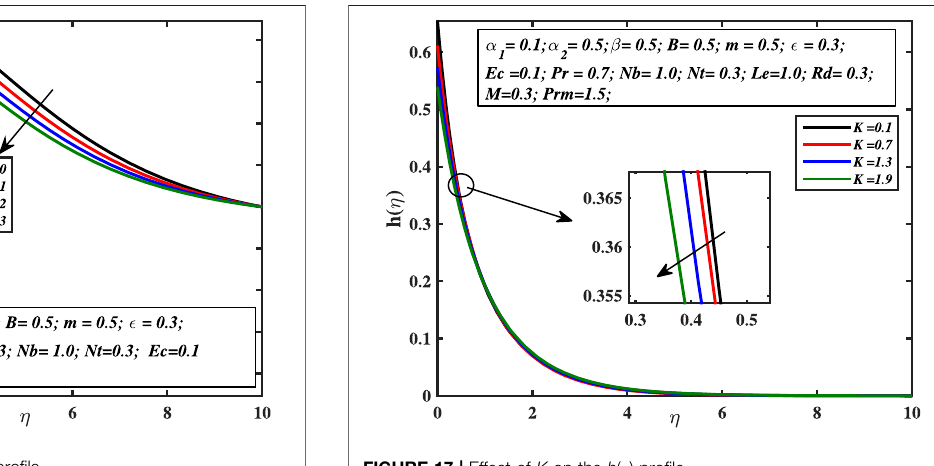
FIGURE 17 | Effect of K on the h ( η ) pro fi le.